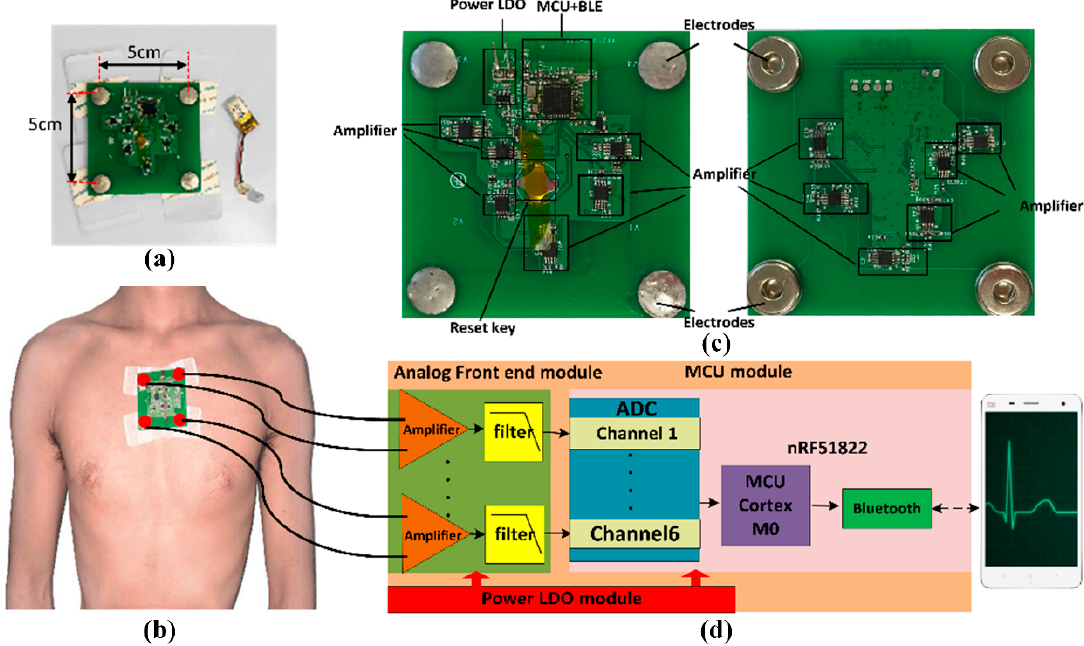
Figure 2. System overview: ( a ) The system look; ( b ) The system mounted on the body of a subject; ( c ) Front and back views of the circuit board; ( d ) Schematic diagram of the hardware.